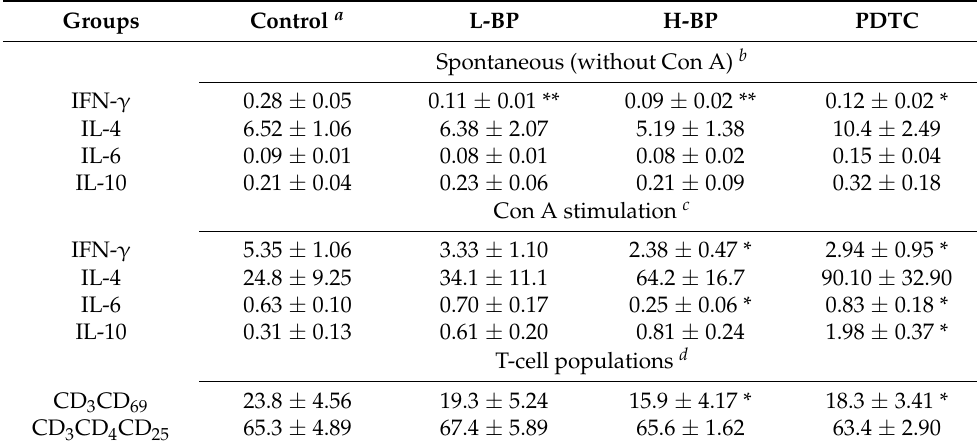
Table 2. The modulatory effects of BP-95E-H 2 O-BuOH extracts on T-cell-related cytokine secretion in spleen cells from LPS-challenged